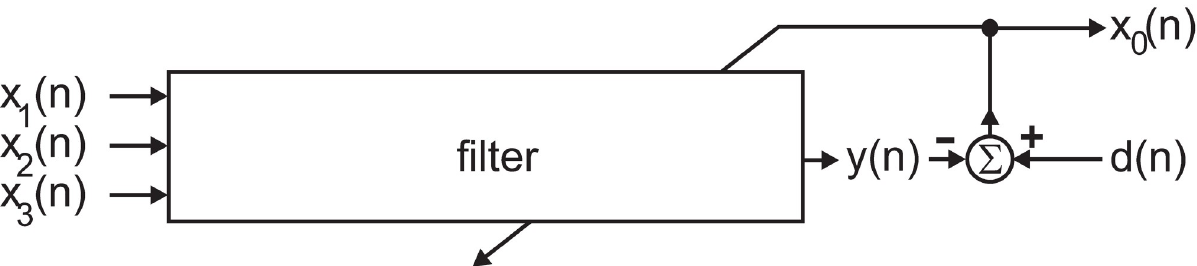
Fig 1. Standard circuit for LMS-based noise